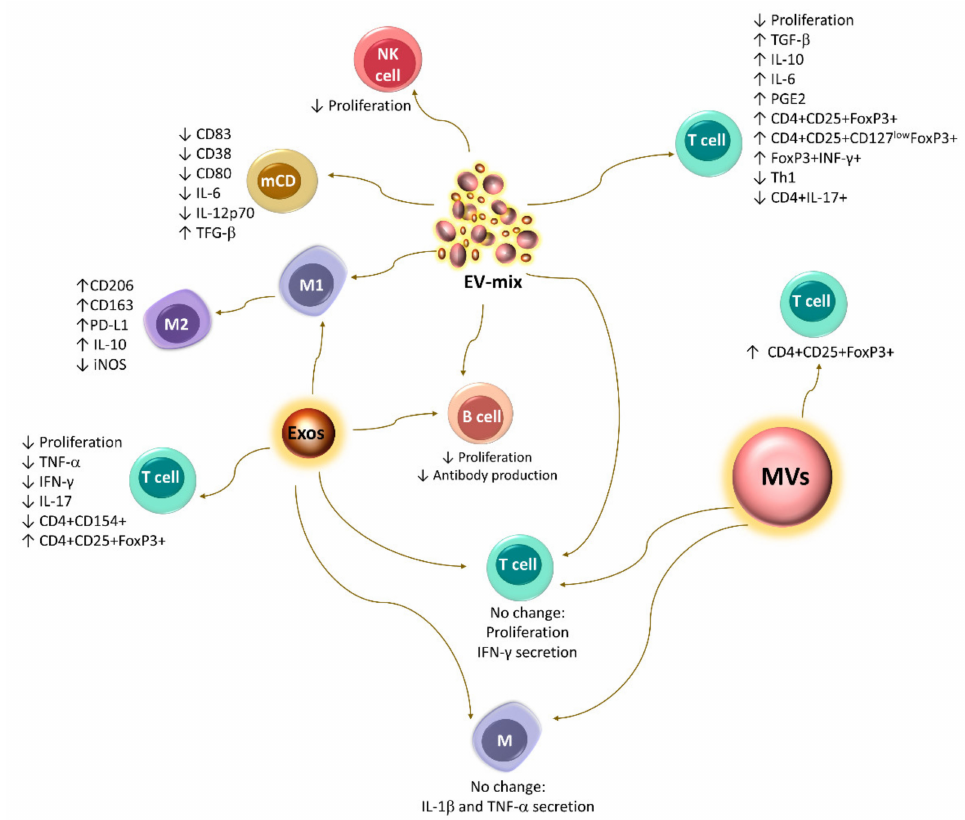
Figure 5. Immunoregulatory effect of EVs released by MSCs. EV-mix preparations decrease the cytotoxic activity of NK cells and the function of mCD, as well as the proliferation of T and B lymphocytes. In addition, they affect the differentiation of Th1 cells while stimulating the differentiation of M2 macrophages and Tregs. However, it has also been reported that this type of preparation does not affect the proliferation and secretion of IFN- γ by T lymphocytes. Similar observations have been made with isolated exosomes (Exos) or MVs and their effect on T lymphocytes and macrophages. Conversely, it has been shown that each of these structures separately favors the differentiation of Tregs; in particular, exosomes decrease the secretion of proinflammatory cytokines by activated T